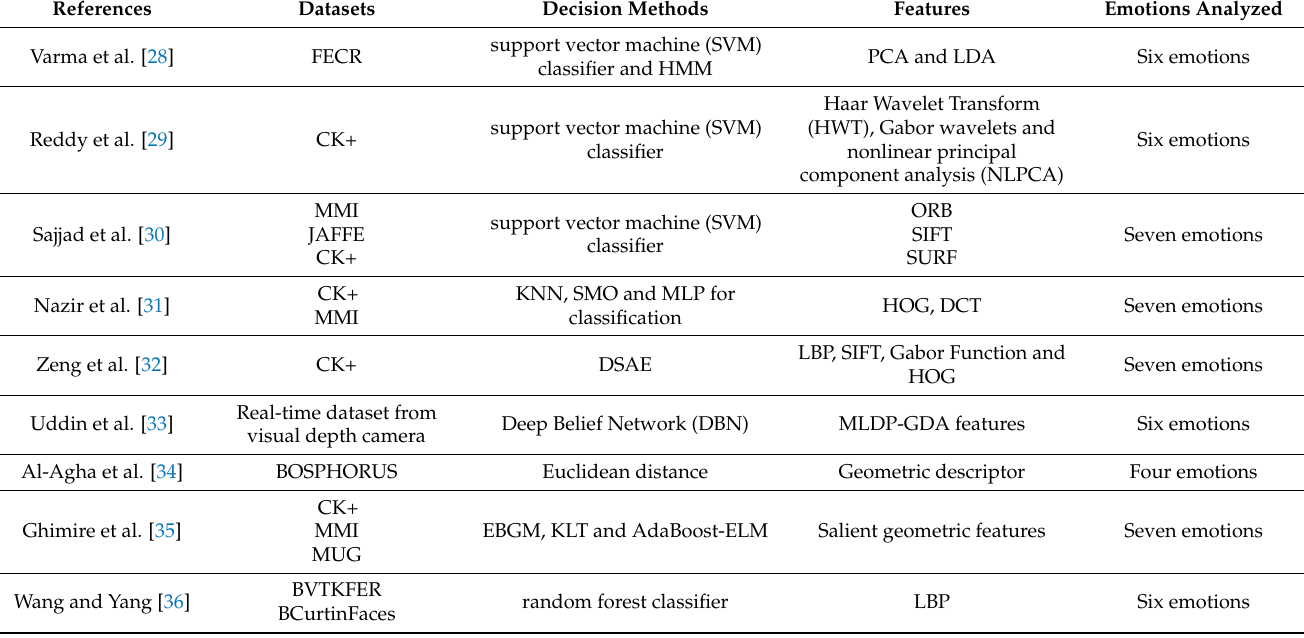
Table 1. Summary of the representative conventional FER